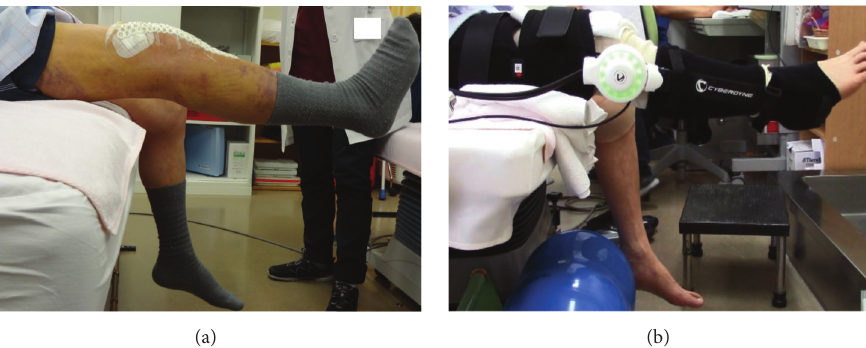
Figure 5: Knee-extension training on postoperative day 8. Active knee extension (a) did not result in full extension, whereas extension with single-joint hybrid assistive limb assistance resulted in full knee extension